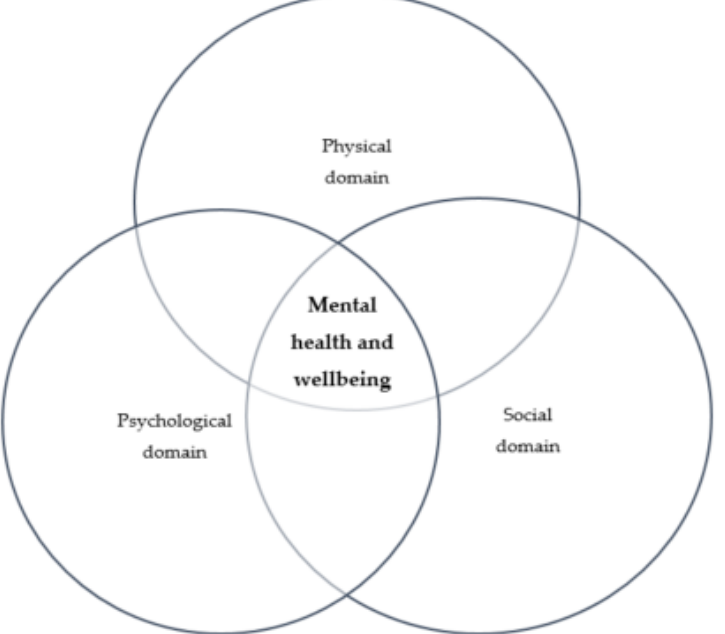
Figure 1. Three-dimensional mental wellbeing framework adapted for the COVID-19 crisis. Adapted from [34].